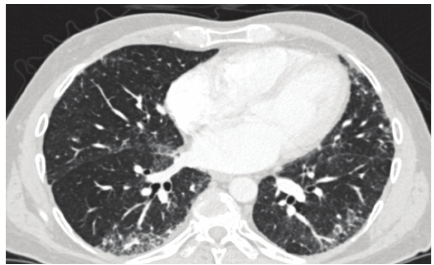
Figure 1: Chest CTA showing subpleural pulmonary fibrosis, inter- and intralobular septal thickening, architectural distortion with traction bronchiectasis and bronchiolectasis, and distortion of interfaces as well as diffuse prominence of the segmental and subsegmental pulmonary arteries with extension of vessels to the lung